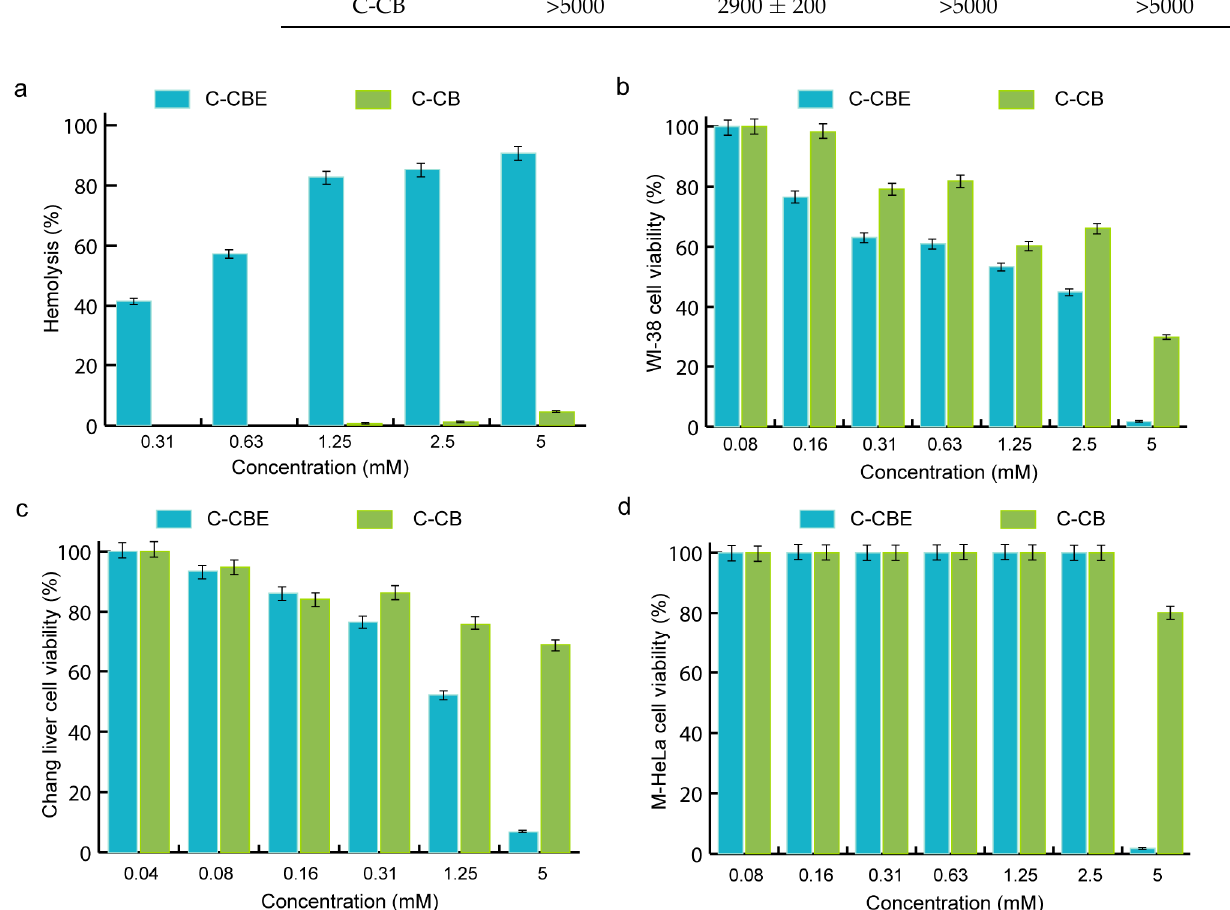
Figure 1. The hemolysis (%) of human red blood cells ( a ), and cell viability (%) of WI-38 cells ( b ), Chang liver cells ( c ), and M-HeLa cells ( d ) in the presence of C-CBE and C-CB.